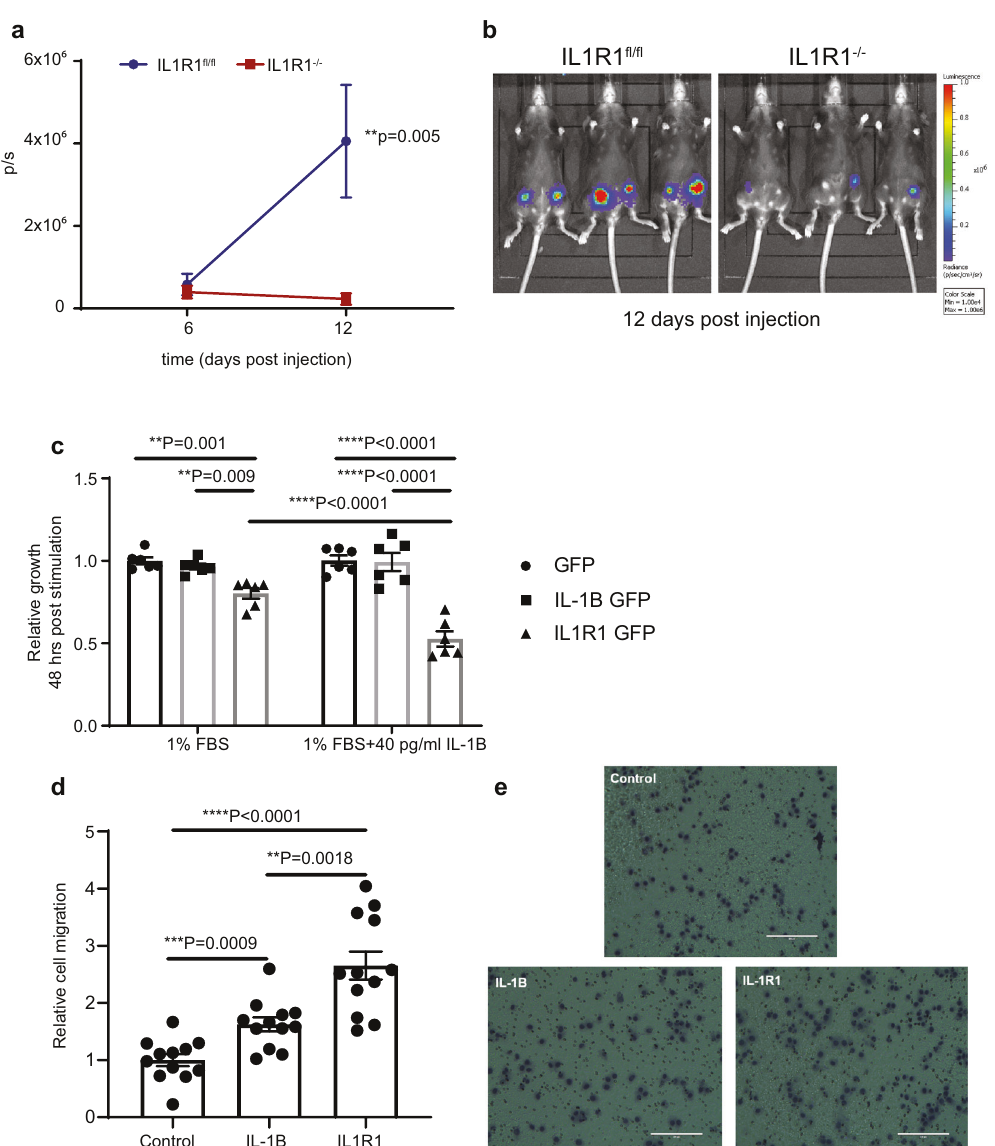
Fig. 4 IL-1B signalling enables breast cancer metastasis initiation. a , b Tumour proliferation after injection of E0771 luc2 V5 IL1R1-GFP cells in IL1R1 fl / fl ( n = 8 primary tumours from n = 4 mice) and IL1R1 − / − ( n = 6 primary tumours from n = 3 mice) mice. Data are mean + / − SEM, Two-way ANOVA with Sidak ’ s multiple comparisons test. c In vitro relative tumour growth of E0771 luc2 V5 GFP, IL-1B GFP or IL1R1 GFP cells upon stimulation with 40 pg/ml mouse recombinant IL-1B. Data are mean ( + / − SEM), Two-way ANOVA with Sidak ’ s multiple comparison test ( n = 6 technical repeats from two biological replicates). d Transwell cell migration of IL-1B overexpressing ( P = 0.0009) and IL1R1 overexpressing ( P < 0.0001) E0771 luc2 V5 cancer cells compared to control GFP-expressing cells (no treatment with exogenous IL-1B). Comparison of cell migration in vitro between E0771 luc2 V5 IL-1B GFP and IL1R1 GFP tumour cells ( P = 0.0018). Data are mean ( + / − SEM) cell number from 4 fi elds of view derived from three biological experiments ( n = 12 technical repeats). Two-tailed unpaired t -test with Welch ’ s correction. e Representative images of haematoxylin-stained control, IL-1B and IL-1R1 overexpressing cells migrated through the membrane. Scale bar = 200